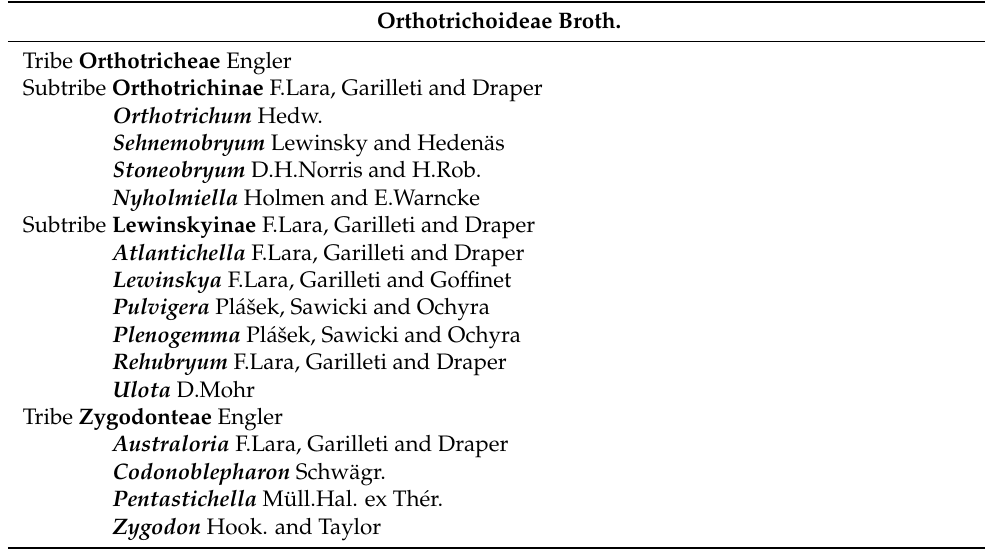
Table 1. Classification of Orthotrichoideae according to Draper et al. [12,13]. Orthotrichoideae